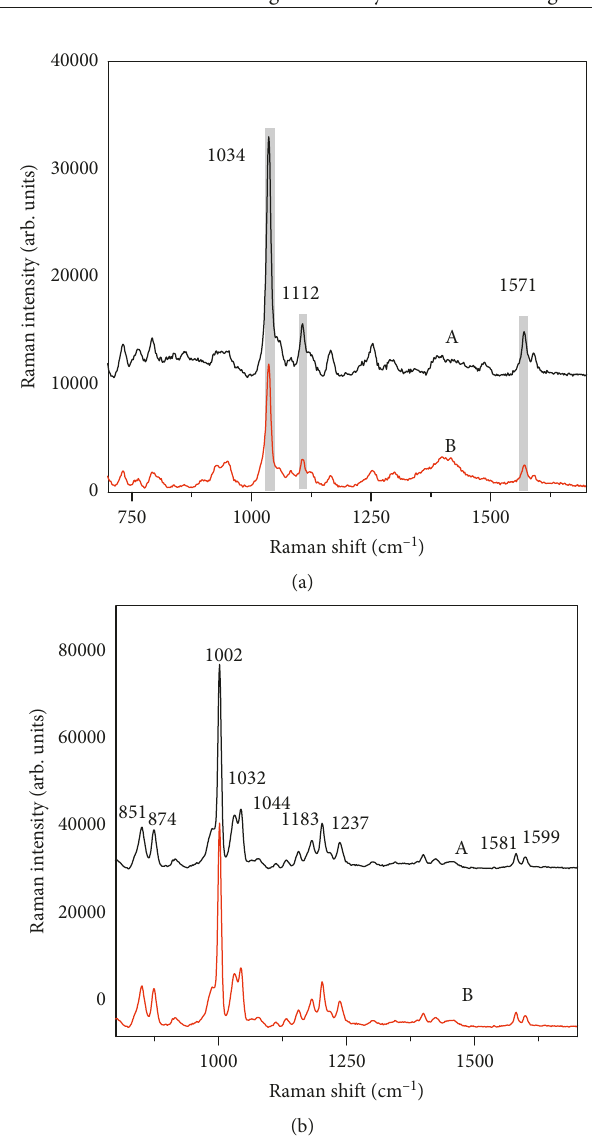
Figure 5: Comparison of the SERS effects of two silver sols with (a) promethazine and (b) scopolamine. A represents the second silver sol in Figure 2 and B represents the first silver sol in Figure 2; both 4 at 5 −